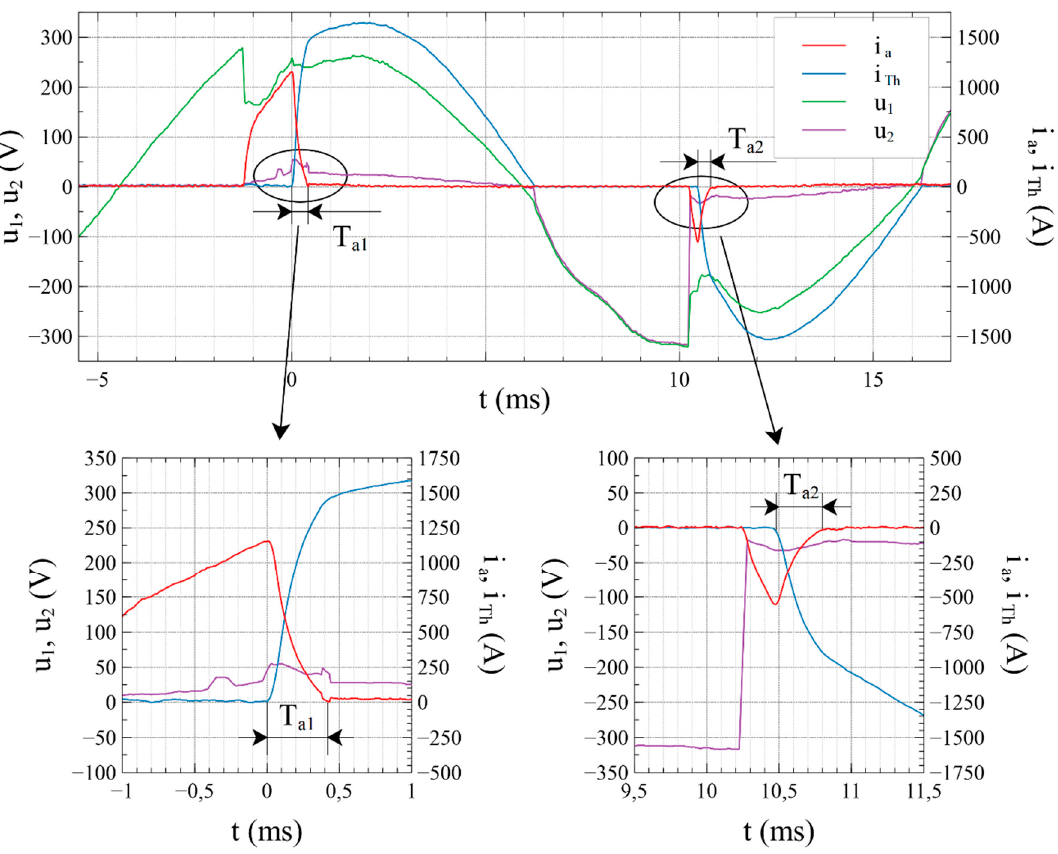
Figure 6. Current waveforms in the load branch ( I a ), current in the thyristor branch ( i Th ), supply voltage ( u 1 ) and voltage measured on the arc source electrodes ( u 2 ) at subsequent arc ignitions ( T a1 = 0.42 ms, T a2 = 0.32 ms).